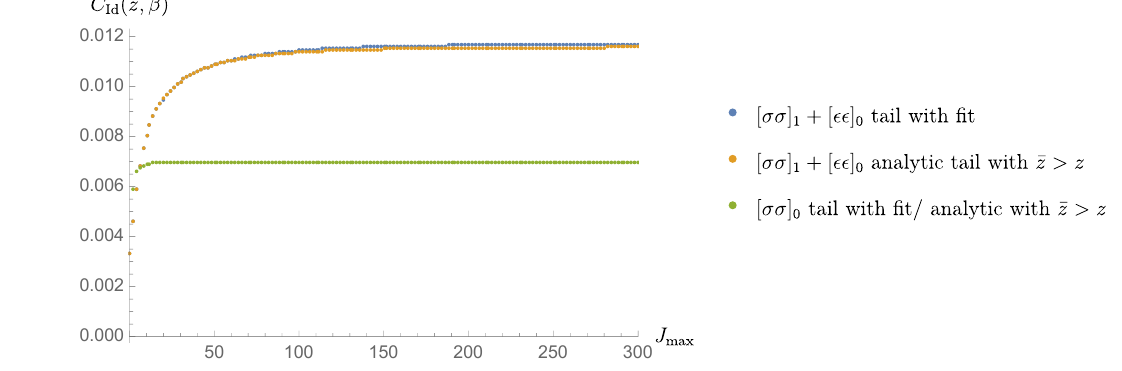
Figure 5 . Partial sums contributing to C ( z =10 − 4 . 5 , β =5) , extrapolated to very large spins. and where ( a ) denotes the Pochhammer symbol which is defined as ( a ) b allows us to estimate the inversion formula in (2.21) at large spin as